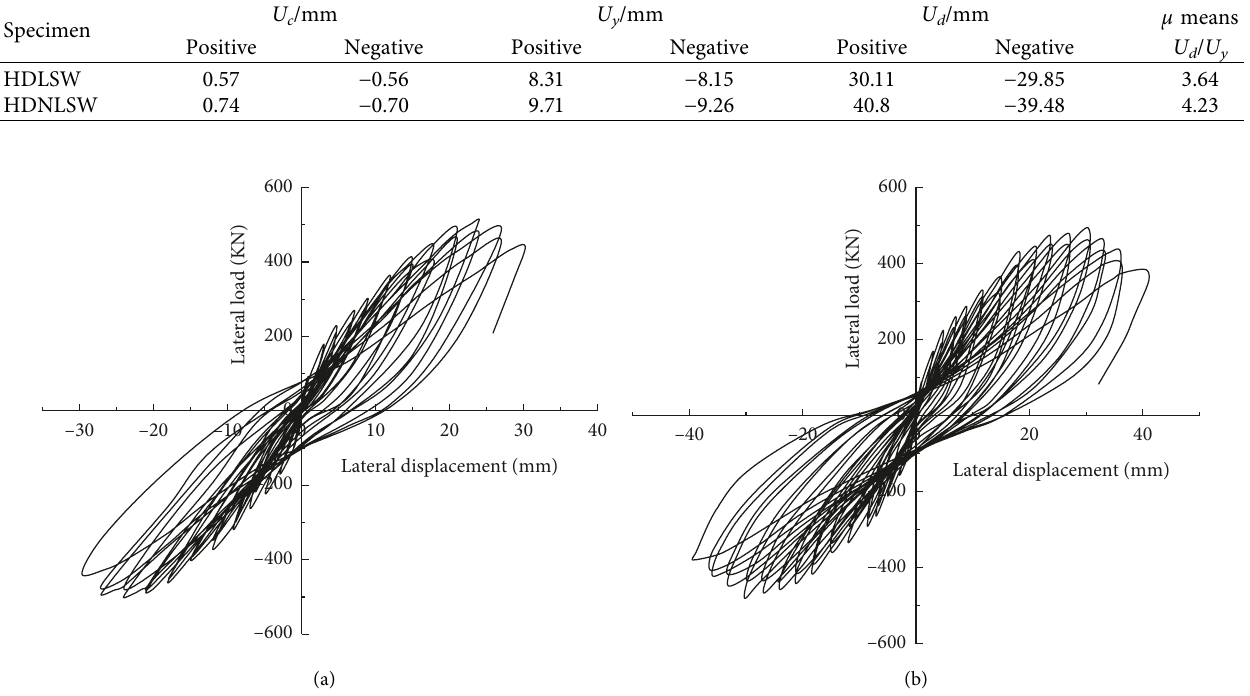
Figure 9: Lateral force versus the top displacement hysteretic curve. (a) HDLSW. (b)